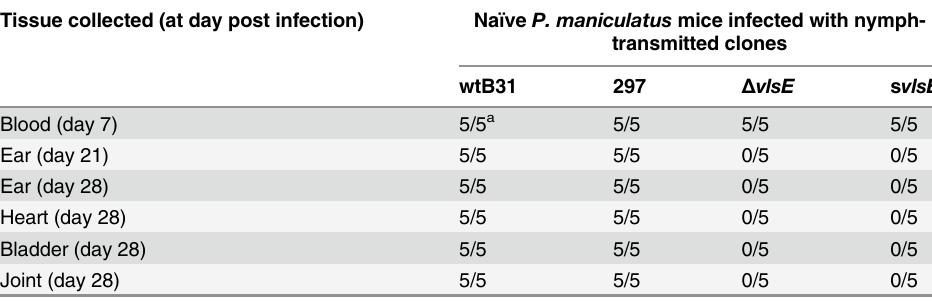
Table 3. Infectivity of nymph-transmitted B . burgdorferi clones in P . maniculatus mice. Tissue collected (at day post infection)